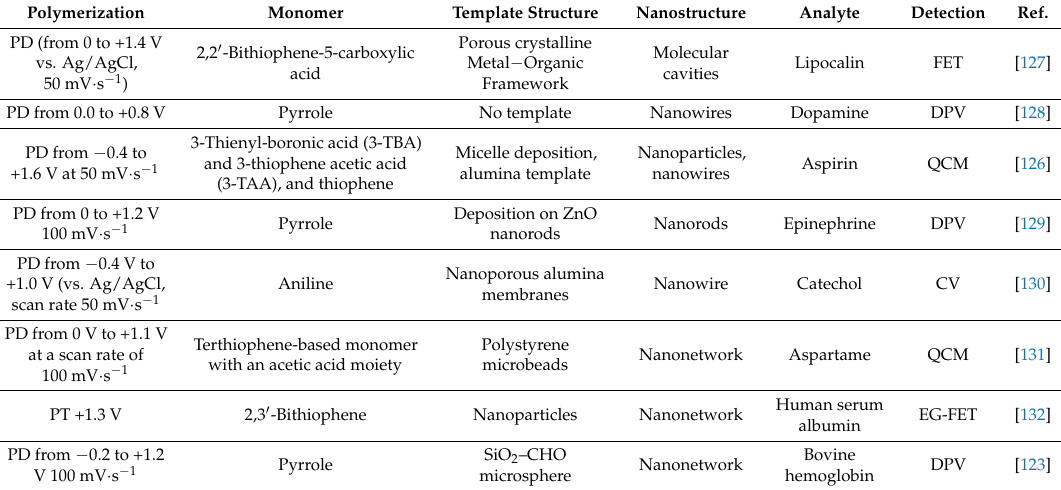
Table 2. Nanostructured MIPs for